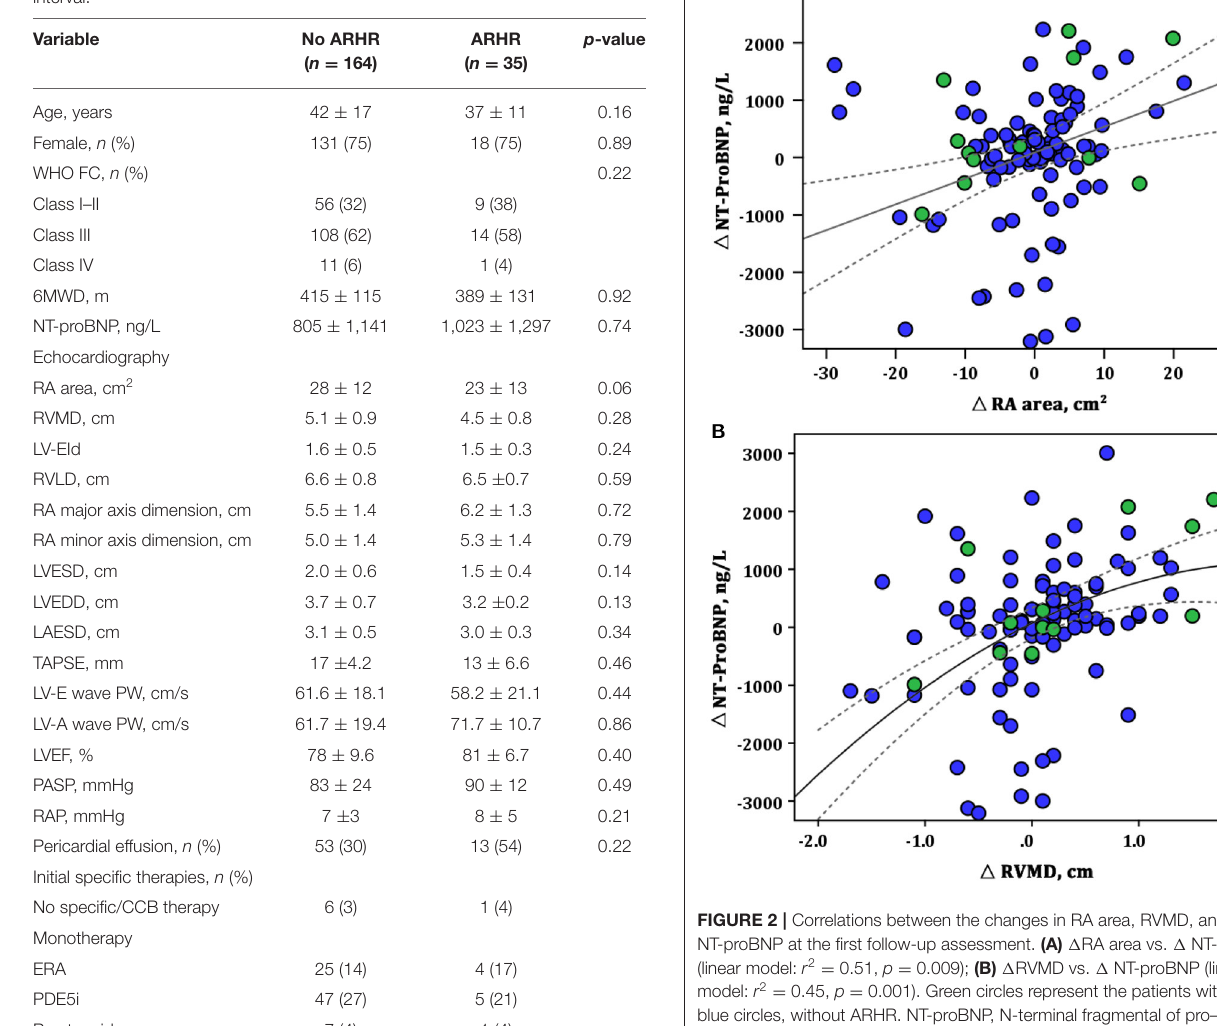
TABLE 2 | Clinical, hemodynamic, and echocardiographic characteristics of two patient groups based on ameliorative right heart remodeling at first follow-up interval.